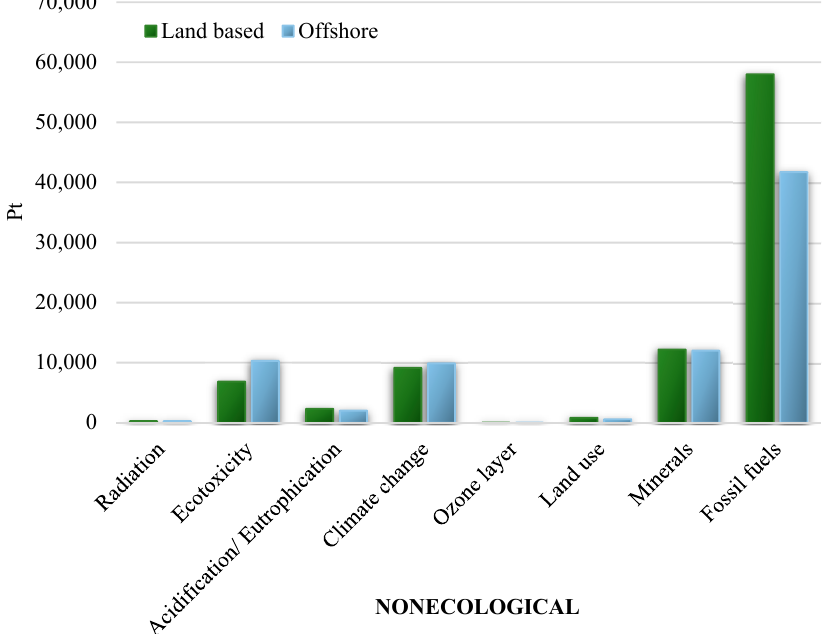
Figure 5. Results of grouping and weighing the environmental effects for ecological impacts involved in land and offshore wind power plant life cycles. Authors’ own research.